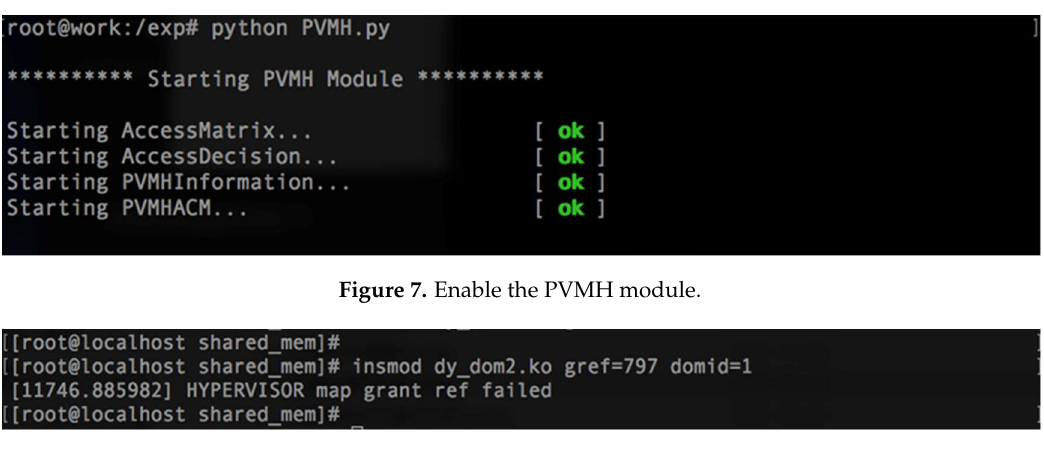
Figure 8. Refer shared memory in VM2, with PVMH enabled.